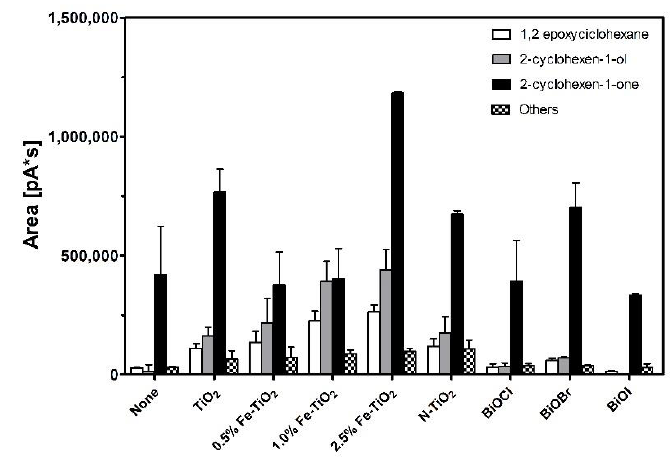
Figure 5. The yield of oxofunctionalized cyclohexene under visible light irradiation. White, gray, black, and checkered columns represent yields of epoxycyclohexane, 2-cyclohexen-1-ol, 2-cyclohexen-1-one, and others, respectively.